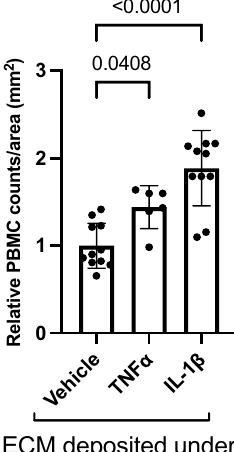
Figure 3. ECM derived from TNFα- or IL-1β-treated hRMEC causes increased PBMC adhesion. Naïve hRMEC monolayers were plated onto ECM derived from TNFα- or IL-1β-treated hRMEC. PBMC were added to naïve hRMEC, allowed to adhere, and washed to remove non-adherent cells. Adherent PBMC were counted in 3 regions per well and averaged. Average counts were then divided by count area. Data are reported as fold